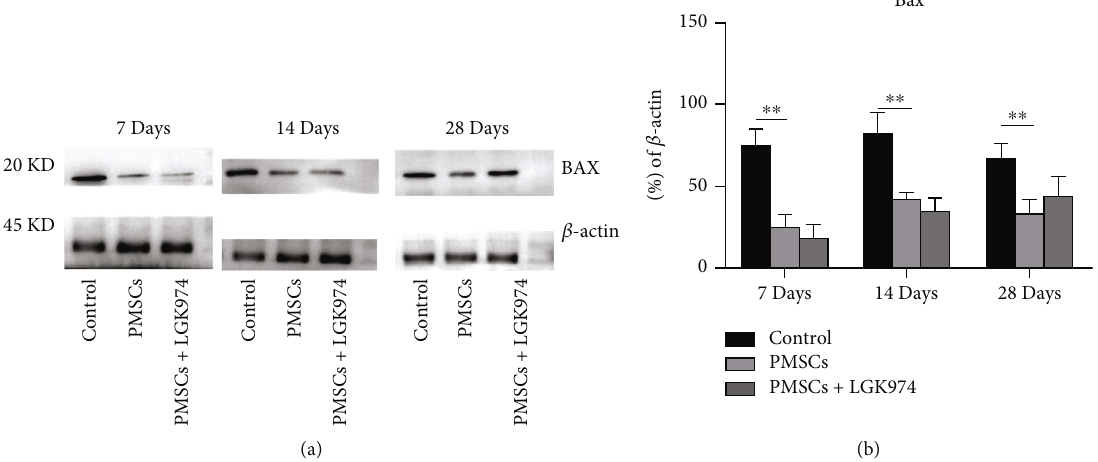
Figure 10: E ff ects of stem cell transplantation on Bax. (a) Bax decreased in PMSC group on 28 days. LGK974 had no signi fi cant e ff ect on Bax. (b) Quanti fi cation of the expression of Bax was summarized. Data were expressed as the mean ± SEM . n = 3 independent experiment; ∗ PMSC group vs. control group, P < 0 : 05 . All samples were taken from the sciatic